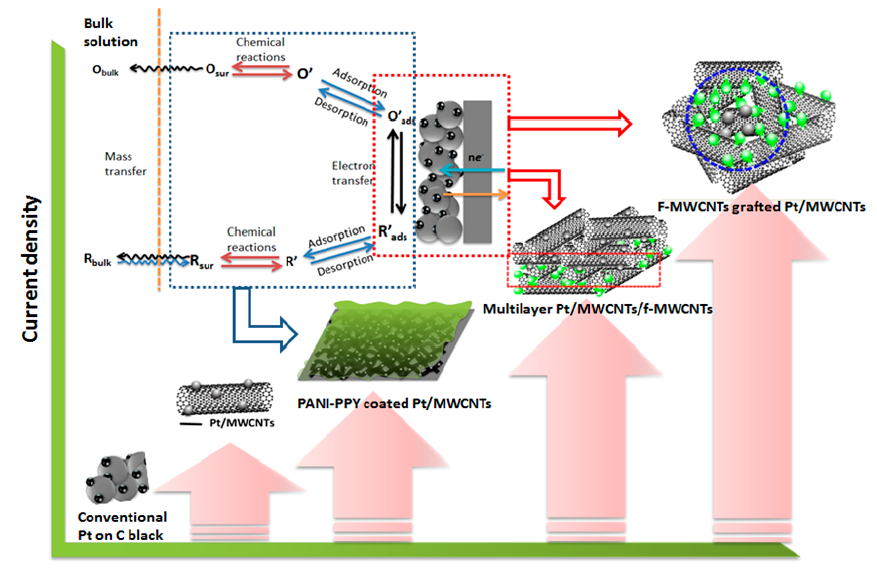
Figure 8. Development of anodic catalytic materials for enhanced direct ethanol fuel cells using co-assembled PANI–PPY and functionalized carbon nanotubes matrices.